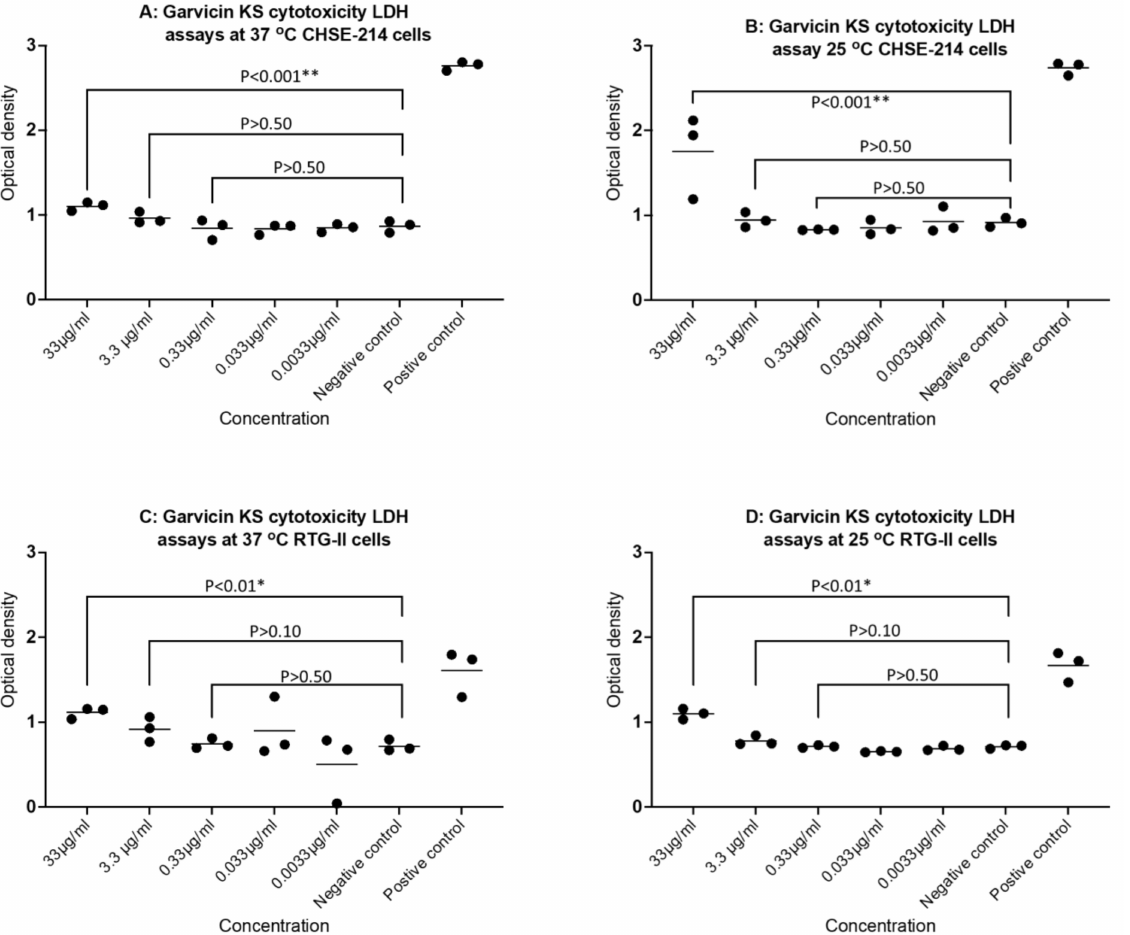
Figure 5. Cytotoxicity LDH test of GarKS on Chinook salmon embryo 214 (CHSE-214) and rainbow trout gill II (RTG-2) cell exposed to concentrations of 33 µ g/mL, 3.3 µ g/mL, 0.33 µ g/mL, 0.033 µ g/mL, and 0.0033 µ g/mL GarKS cultured at 37 ◦ C and 25 ◦ C. Negative control represents cells exposed to PBS while positive control represents cells treated with the LDH solution based on manufacturers’ guidelines (CyQUANT™ LDH, ThermoFisher Scientific, Waltham, MA, USA). Upper channel shows GarKS treated CHSE 214 cells cultured at 37 ◦ C ( A ) and 25 ◦ C ( B ) while the lower channel shows GarKS treated RTG-2 cells cultured at 37 ◦ C ( C ) and 25 ◦ C ( D